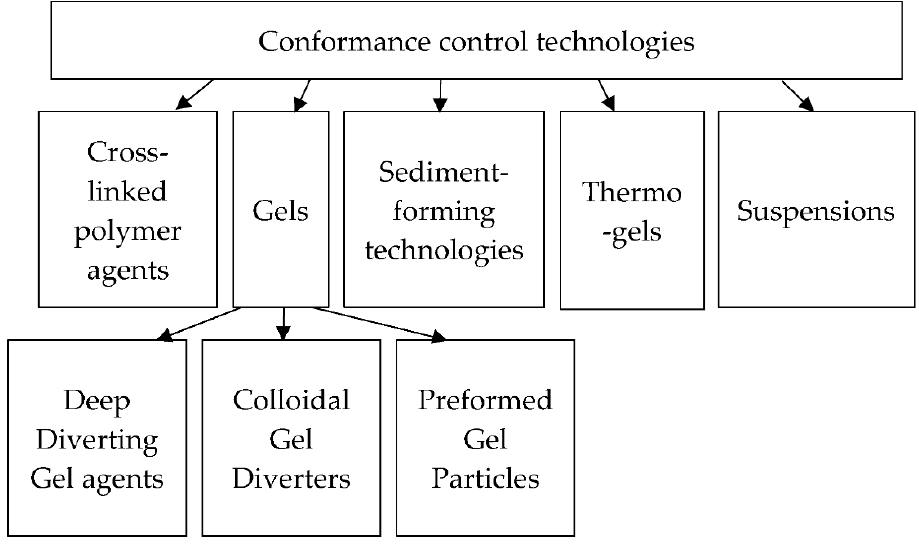
Figure 1. Various conformance control